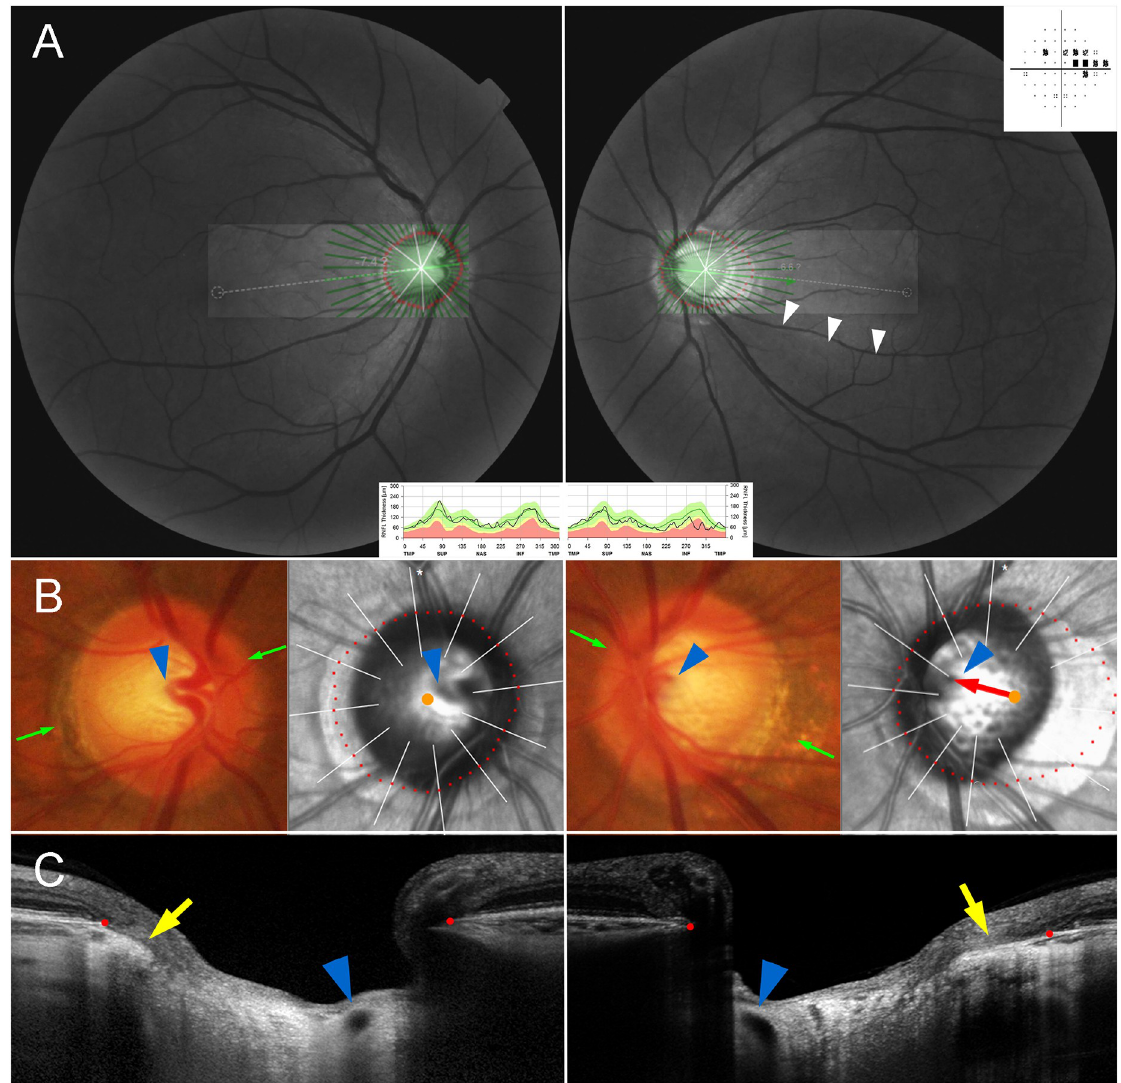
Fig 3. Inter-eye comparison of central retinal vascular trunk (CRVT) positions located on nasal side. ( A ) Red-free fundus photos and Humphrey visual field results. The infrared funduscopic spectral-domain (SD) OCT image is transposed to show the Bruch’s membrane opening (BMO) margin (red dots). The red-free fundus photos show inferior retinal nerve fiber layer (RNFL) defect in the left eye only (white arrowheads). The Humphrey visual field results show superior scotomas corresponding to the RNFL defect. Circumpapillary RNFL thickness maps, as measured by SD-OCT, are given at the bottom for comparison. ( B ) Disc photographs and infrared fundus images. The red dots indicate the BMO margin. The orange dots indicate the centers of the BMO. The arrowheads indicate the CRVT. The green arrows indicate the locations of the SD-OCT scans. Please note the larger offset in the glaucoma eye (red arrow). ( C ) B-scan SD-OCT images show emergence of CRVTs (arrowheads). Please note the larger offset in the glaucoma eye as evidenced by the position of the CRVT (arrowheads) and the difference of the externally oblique borders (yellow arrows) on the temporal